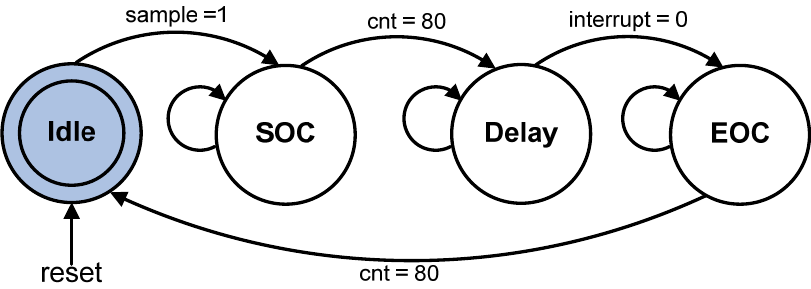
Figure 9. Analog-to-digital converter (ADC) Data Acquisition state diagram.